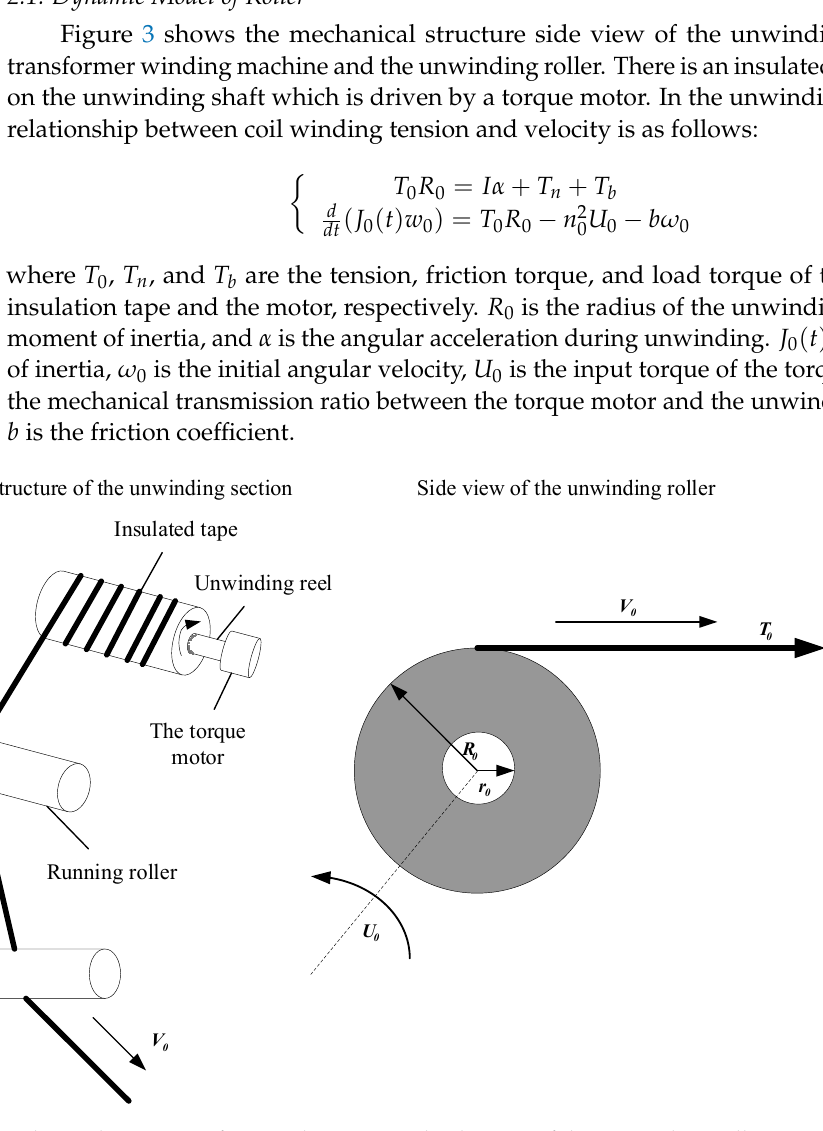
Figure 3. Mechanical structure of unwinding part and side view of the unwinding roller.